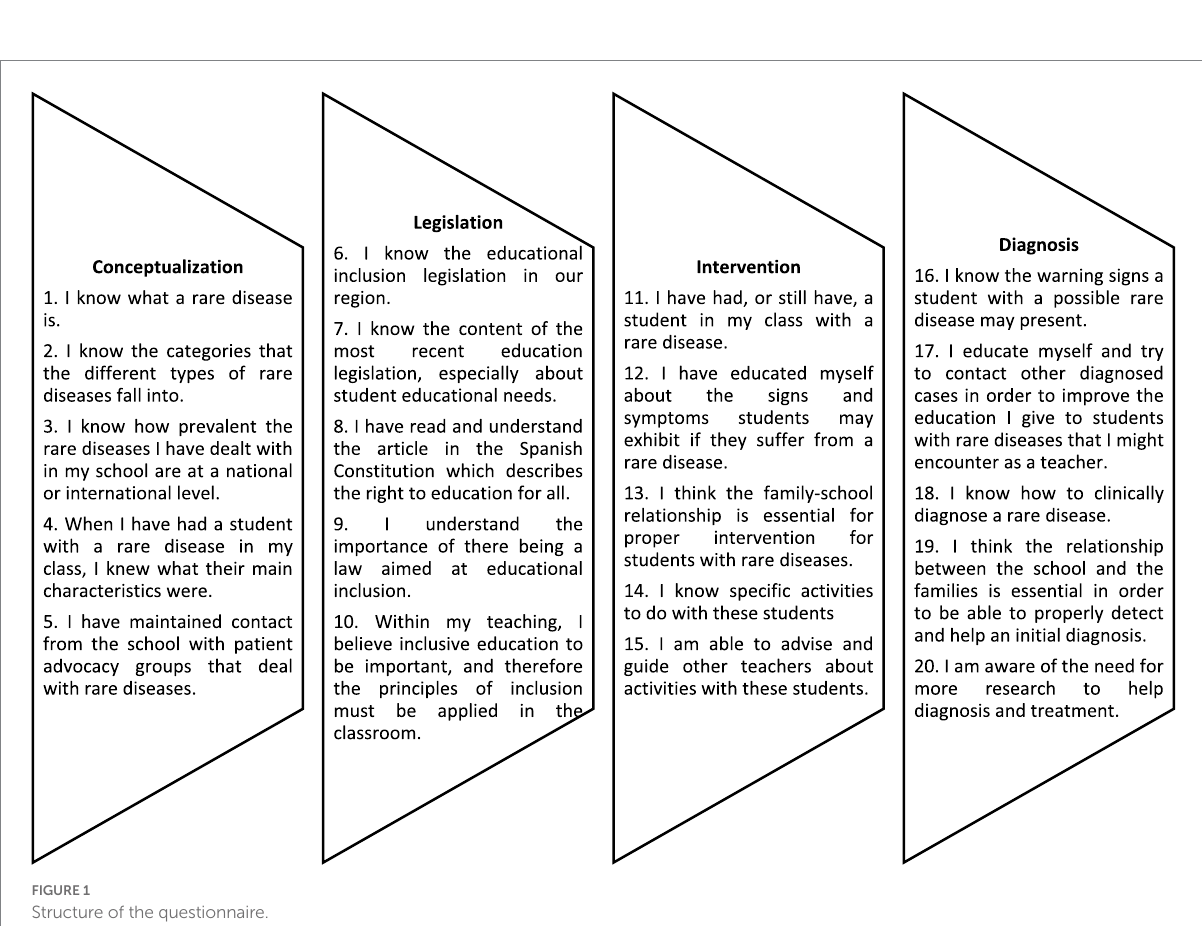
FIGURE 1 Structure of the